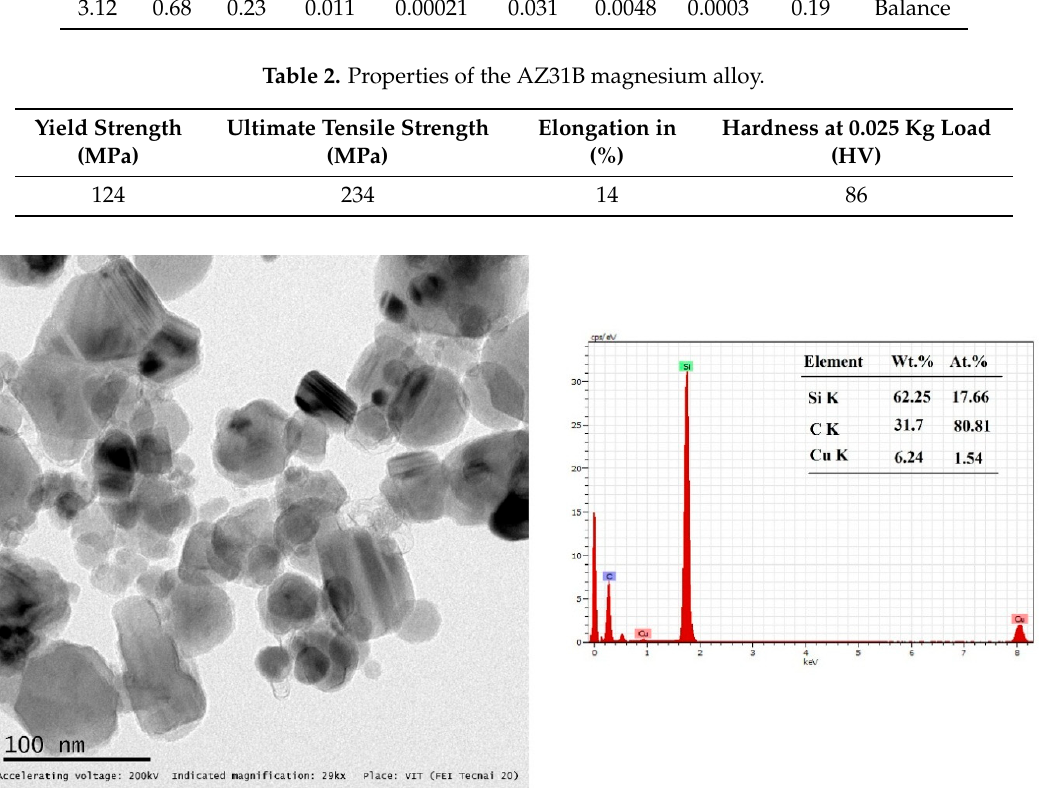
Figure 1. TEM micrograph with energy-dispersive X-ray spectroscopy (EDS) analysis of as-received SiC nanoparticles.